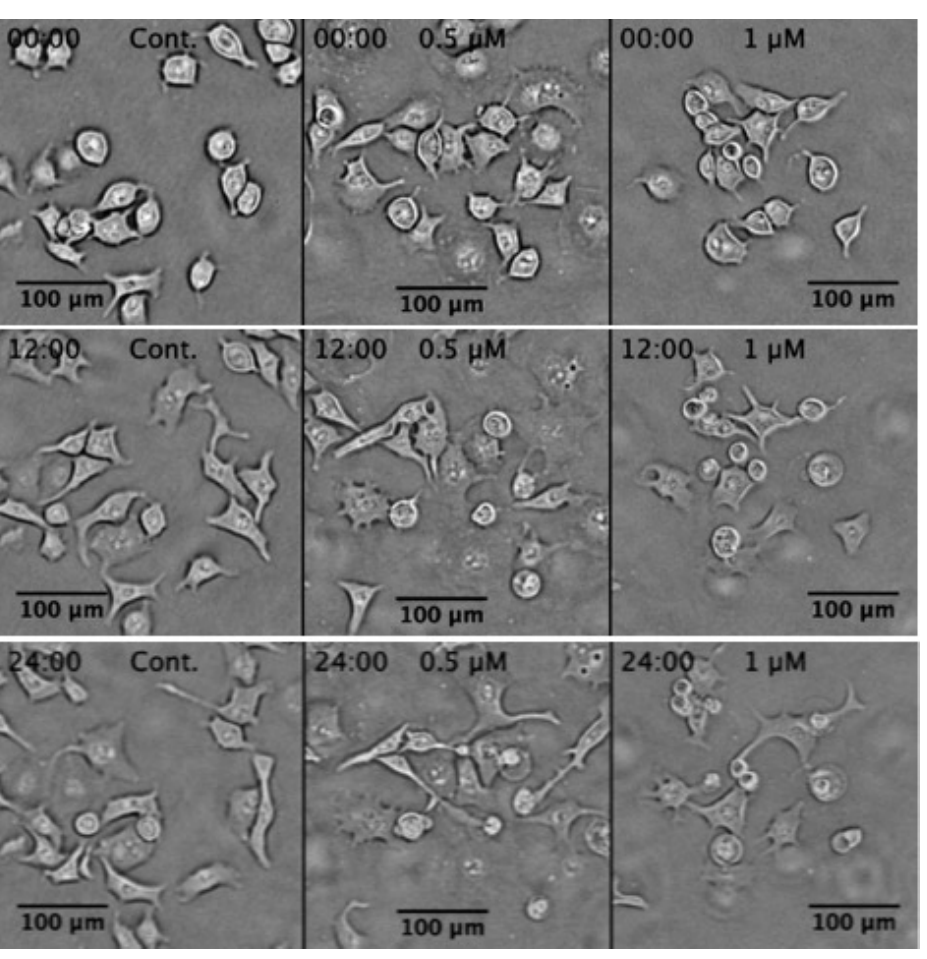
Figure 5. Morphology changes of PANC-1 cells induced by myrtucommulone A ( 2 ) at concentrations of 0.5 and 1 µM, incubated for 24 h in nutrient-deprived medium (NDM) compared with control PANC-1 cells. (See Supplementary Video S1).